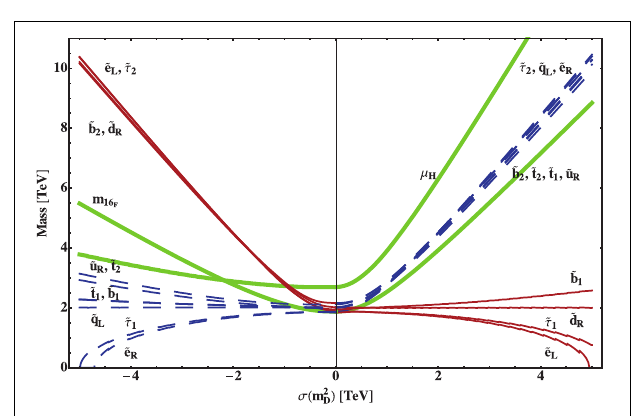
FIGURE 7 | As Figure 5, but with the remaining model parameters fixed as described in Equation